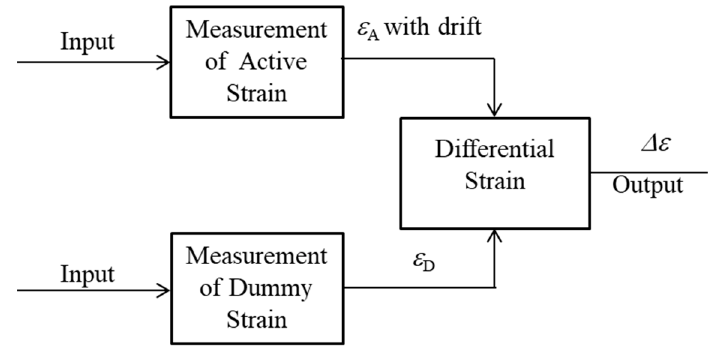
Figure 2. The concept of ACSSM with an active dummy method.